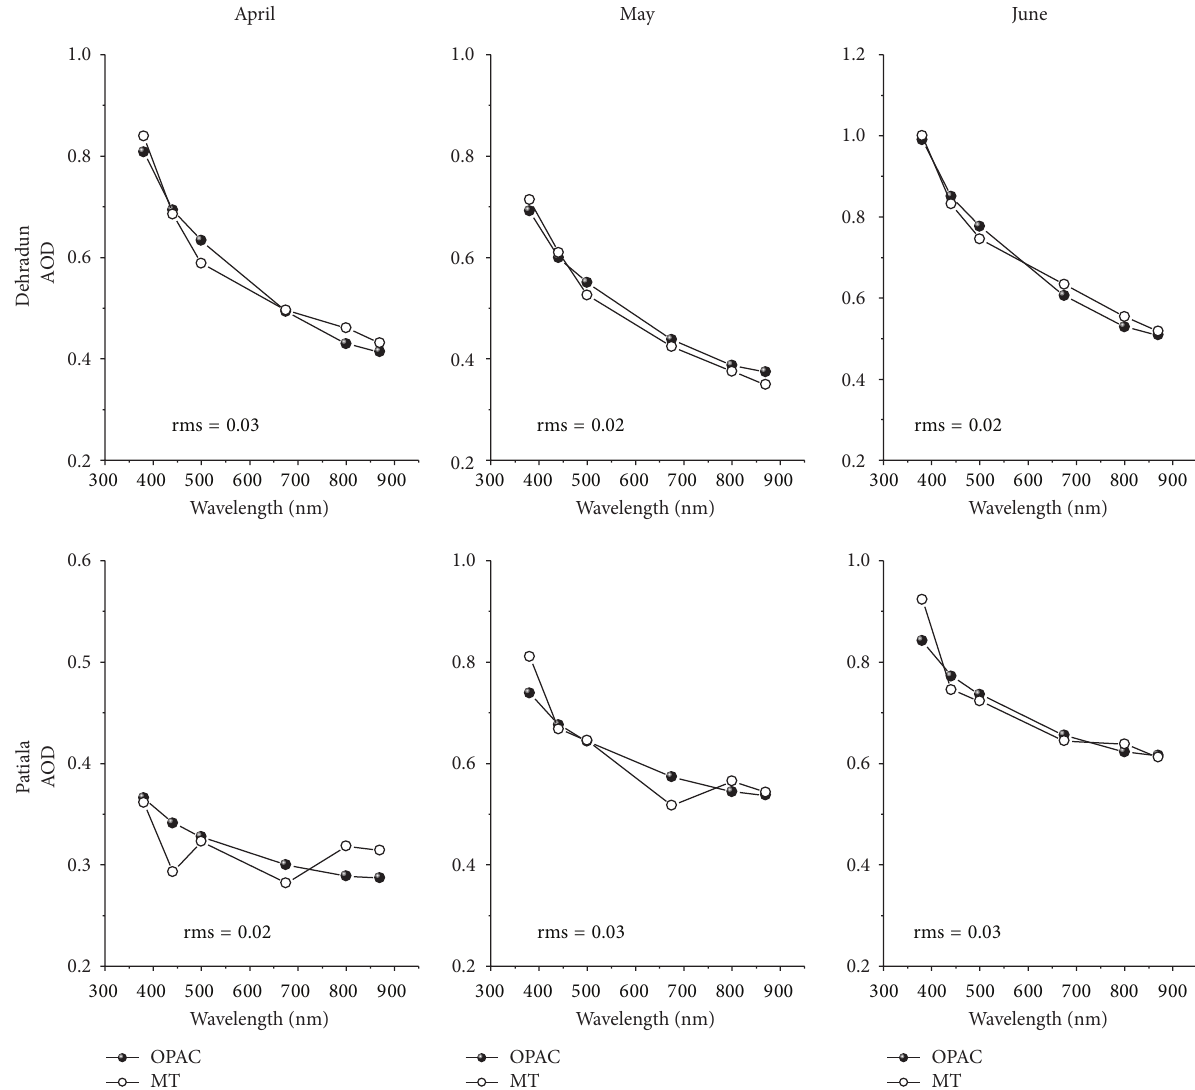
Figure 1: Intercomparison of OPAC derived spectral AOD with Sunphotometer measured spectral AOD over Dehradun and Patiala.